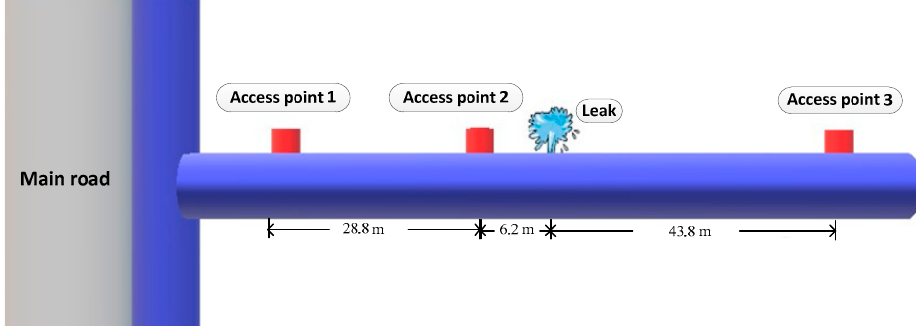
Figure 9. Schematic of the test site located at the IACAS.